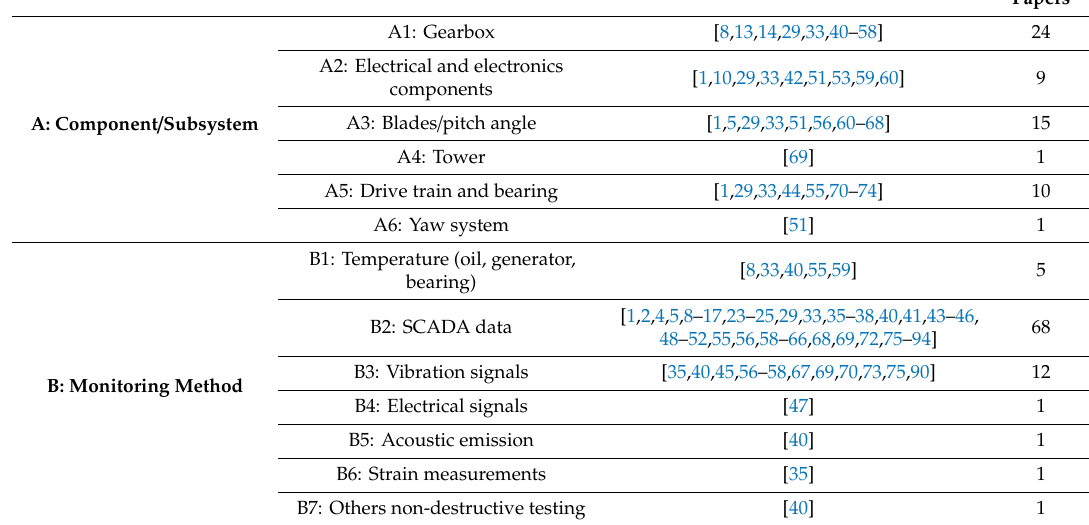
Table 6. Articles on WT components to which CM techniques are